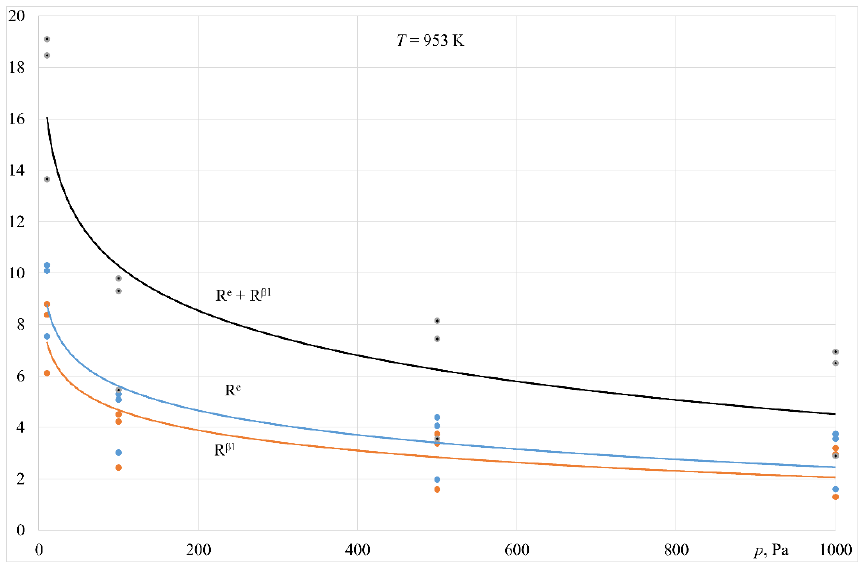
Figure 10. Variation in the resistance of mass transfer in the liquid phase ( R βl ) and reaction on the surface of the liquid metal ( R e ) in overall resistance of evaporation process vs. pressure (crucible induction furnace).